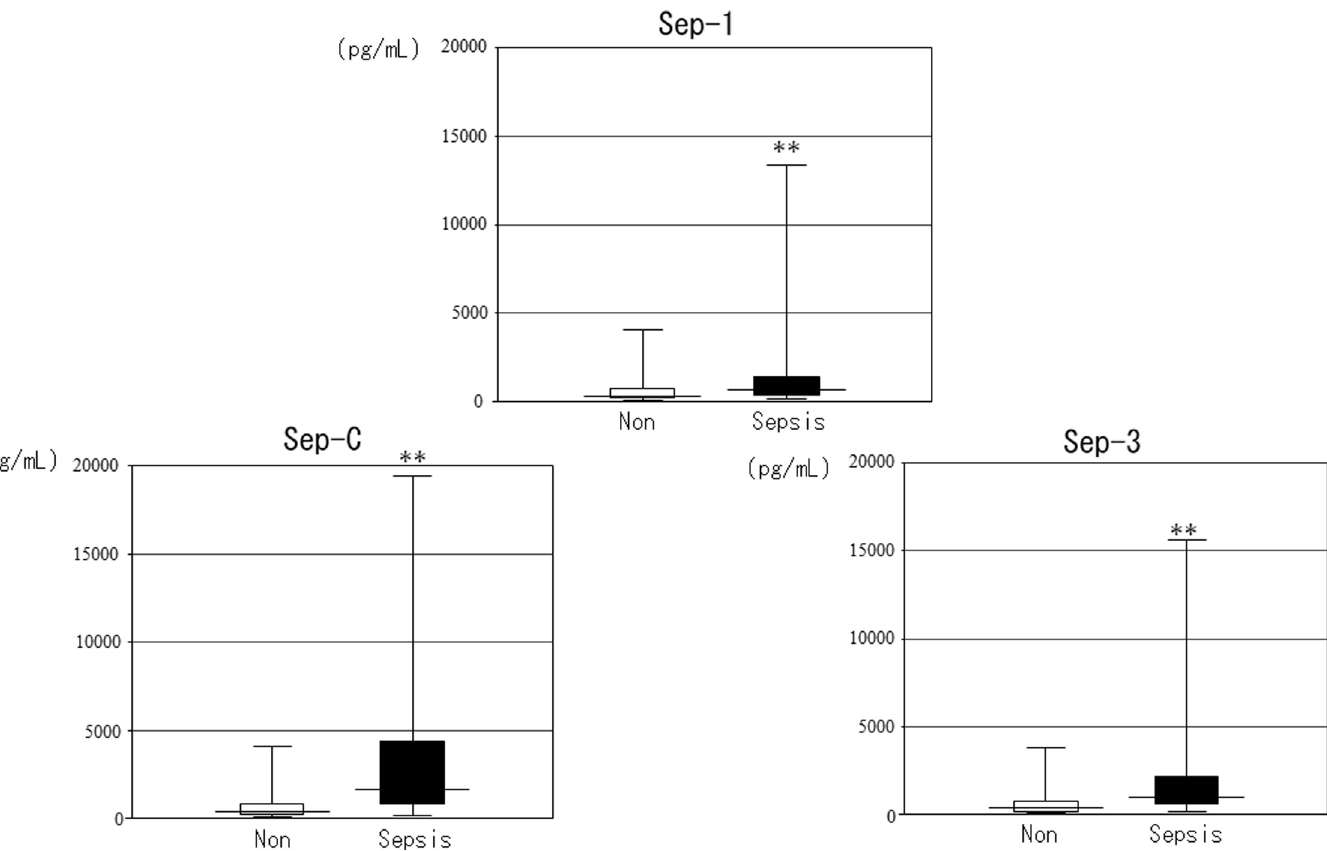
Fig 4. Comparison of Pre levels in patients with and without each sepsis diagnosis [All subjects with infectious diseases (N = 595)]. The horizontal bars represent the median, the boxes represent the IQR, and the vertical bars represent the upper and lower limits. Non: The group of non-septic patients. Sepsis: The group of septic patients. The median Pre (IQR) values are as follows: Sep-1: Sepsis (N = 282), 693 (351–1400) vs. Non (N = 313), 392 (230–874) pg/mL; Sep-C: Sepsis (N = 72), 1628 (867– 4372) vs. Non (N = 524), 454 (263–954) pg/mL; Sep-3: Sepsis (N = 107), 1036 (600-–2152) vs. Non (N = 373), 430 (117–874) pg/mL. � p < 0.05, �� p < 0.01 by the Mann– Whitney U test vs.